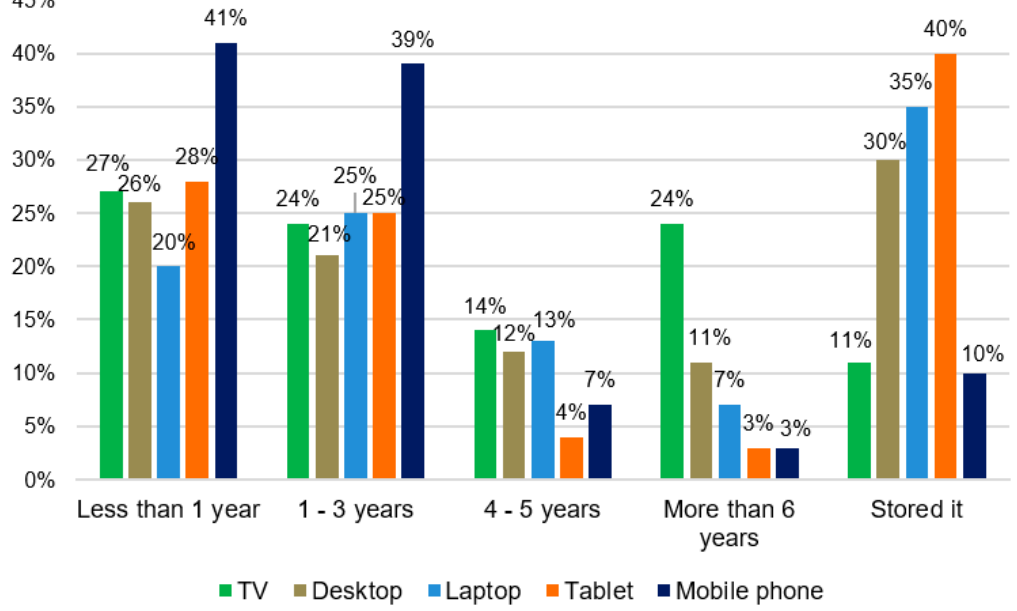
Figure 3. Time of use of electronic equipment before disposal (percentage). Source: Own elaboration based on the results obtained from the national survey (2018).